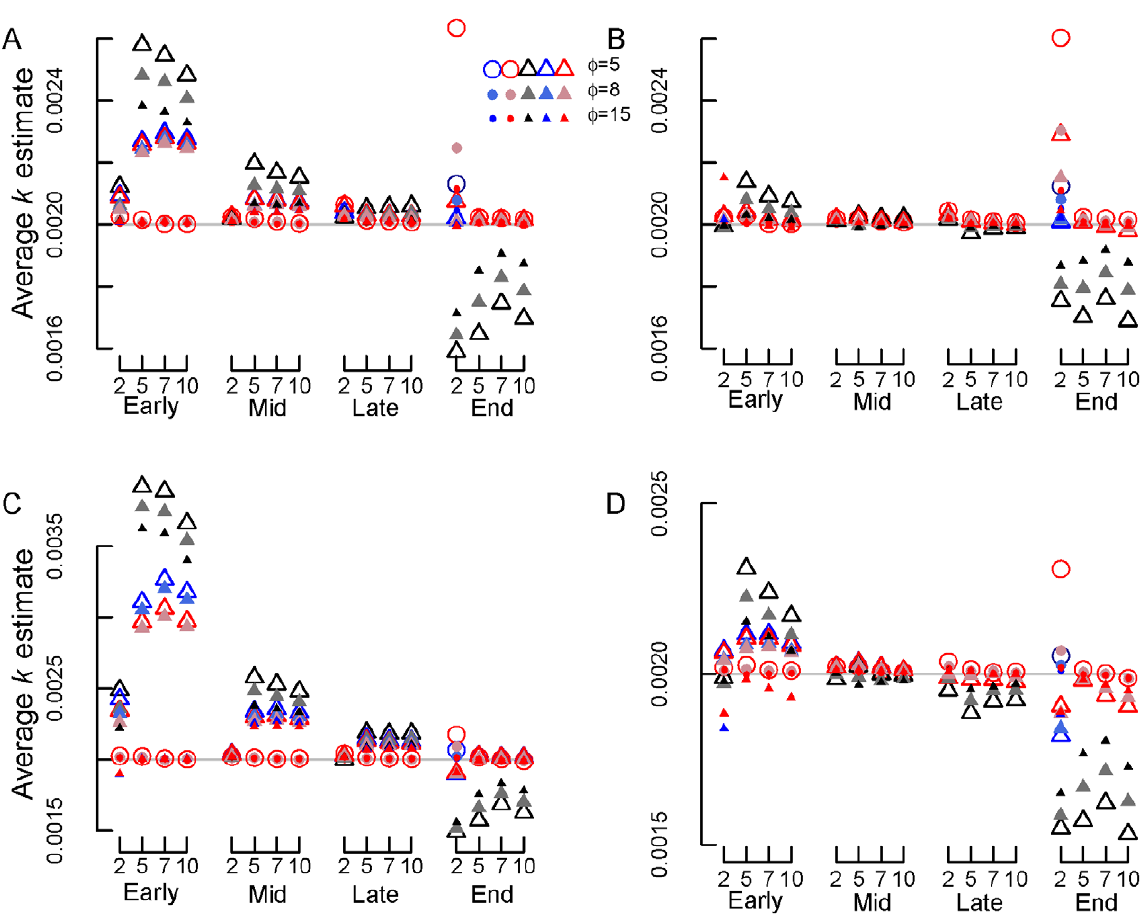
Figure 6. Average k estimates for beta-distributed errors plus normal errors with different s and transformations. (A) s =0.0125 (option 3a) and SV transformation, (B) s =0.0125 (option 3a) and REP transformation, (C) s =0.05 (option 3b) and SV transformation, (D) s =0.05 (option 3b) and REP transformation. Early, mid, late and end are early, mid, late and end stage decomposition simulations. The numbers 2, 5, 7 and 10 are the numbers of measurements used in each simulation. Blue circles=NLS, Red circles=Normal ML, gray/black circles=Beta ML. In most cases, nls=Normal ML so that the red circles cover the blue circles. Gray lines show the true k value of 0.002 d 2 1 .